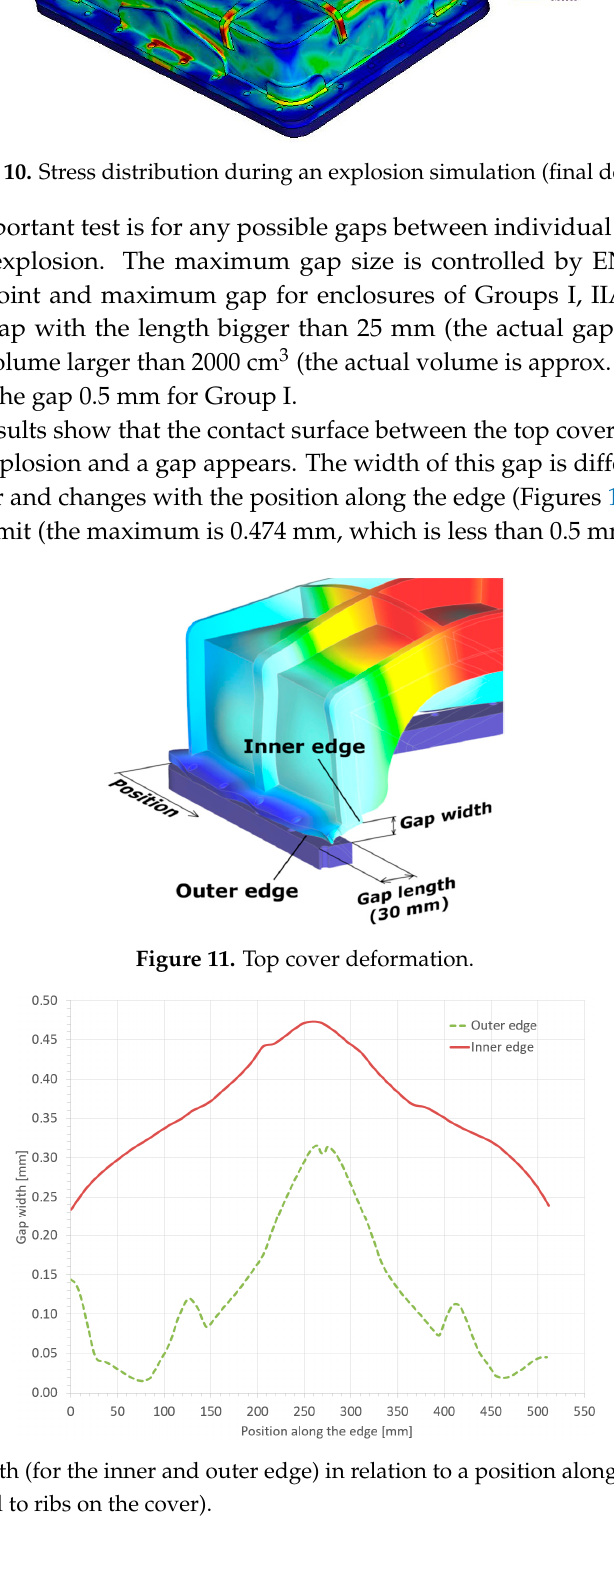
Figure 9. Stress distribution during an explosion simulation (initial design).